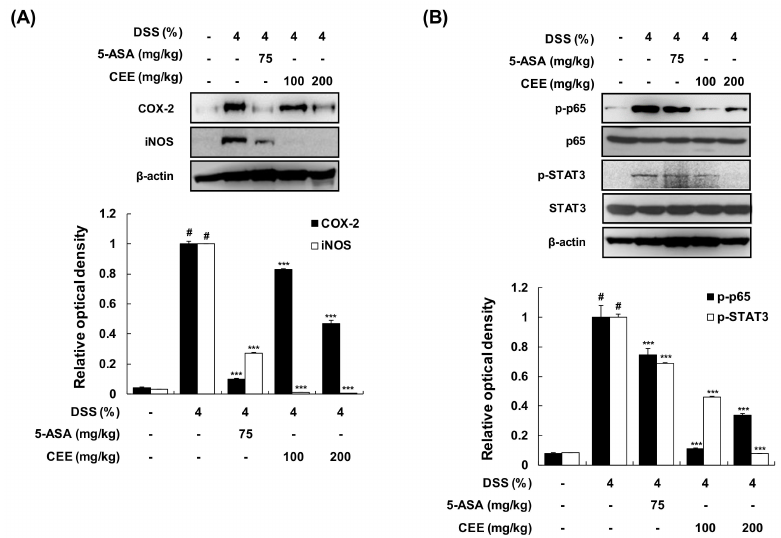
Figure 6. E ff ects of CEE on inflammation-related proteins and transcription factors in mice with DSS-induced colitis. After administration with or without CEE (100 or 200 mg / kg / day p.o.) for 9 days, whole protein extracts were prepared from DSS-exposed colonic tissues. ( A , B ) The protein expression levels of COX-2, iNOS, p-p65, and p-STAT3 were evaluated by western blot analysis. β -Actin was used as an internal control. The ratio of relative optical density was calculated by densitometric analysis and normalized to the internal control. Data are presented as the mean ± SD of three independent experiments. # p < 0.001 vs. the control group; *** p < 0.001 vs. the DSS-fed colitis